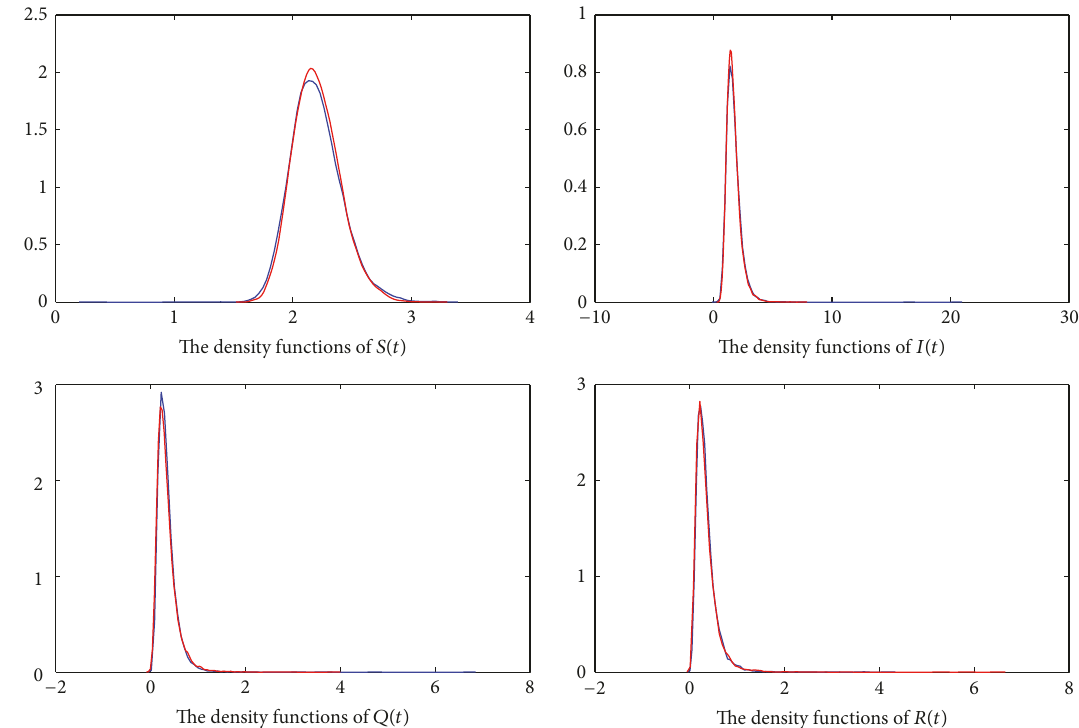
Figure 3: The blue line corresponds to the density function of the solution with 𝑆(0) = 0.3, 𝐼(0) = 0.3, 𝑄(0) = 0.2 , and 𝑅(0) = 0.2. Based on the 10000 sample paths, after iterating 10,000 times. The red line corresponds to the density function of all states that one trajectory of model (3) reaches. Here Δ𝑡 = 1